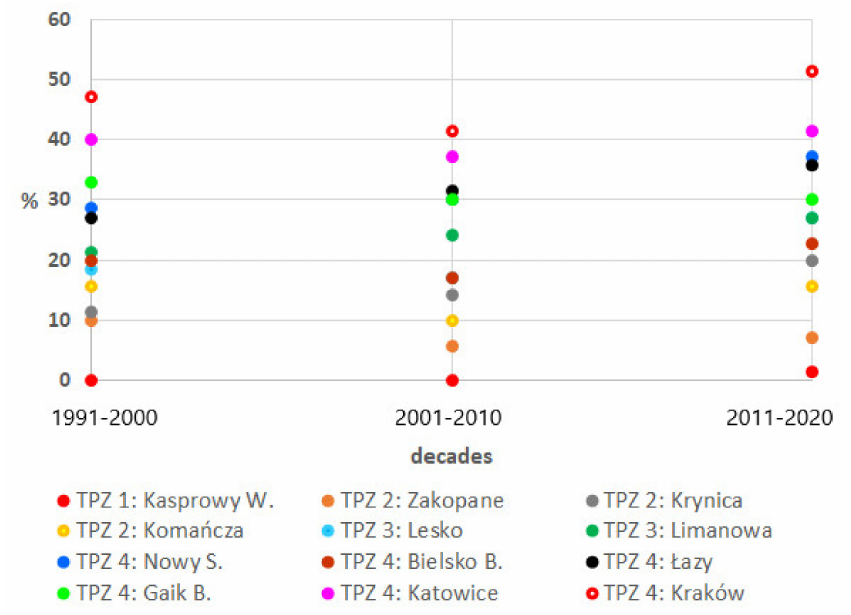
Figure 7. Percentage of dry months according to the Selianinov index for the subperiod April–October in the decades of the study period. Stations are ordered following the concept of TPZ explained in Section